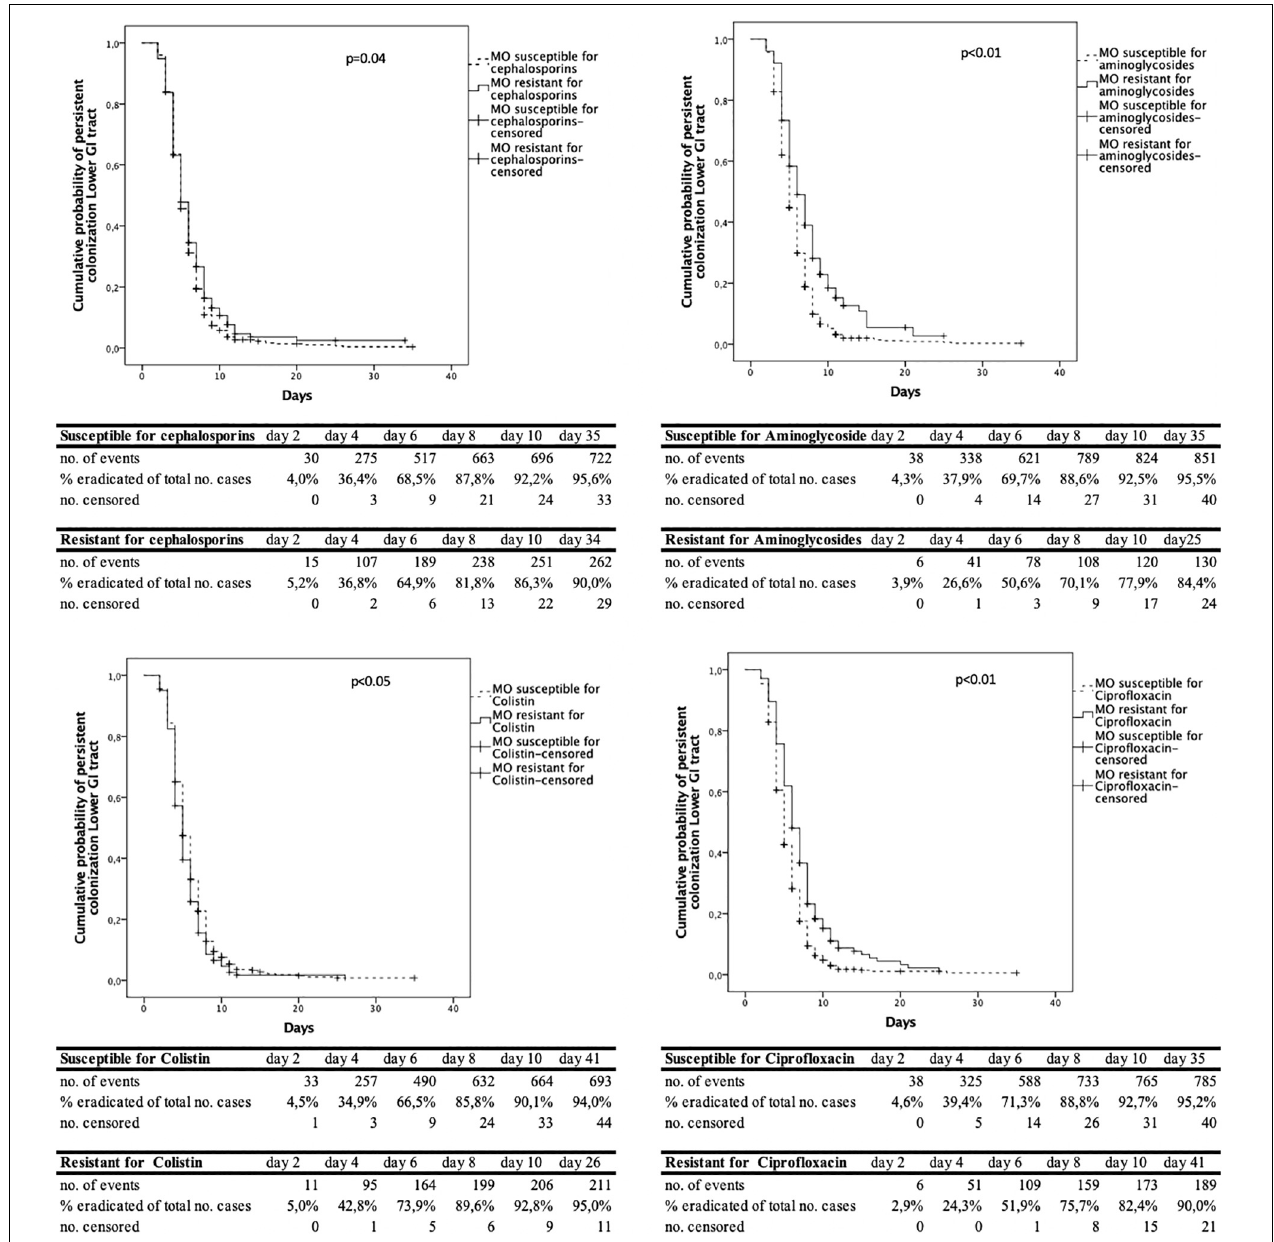
FIGURE 3 | Cumulative decontamination over time for susceptible and resistant microorganisms for the lower gastrointestinal (GI)